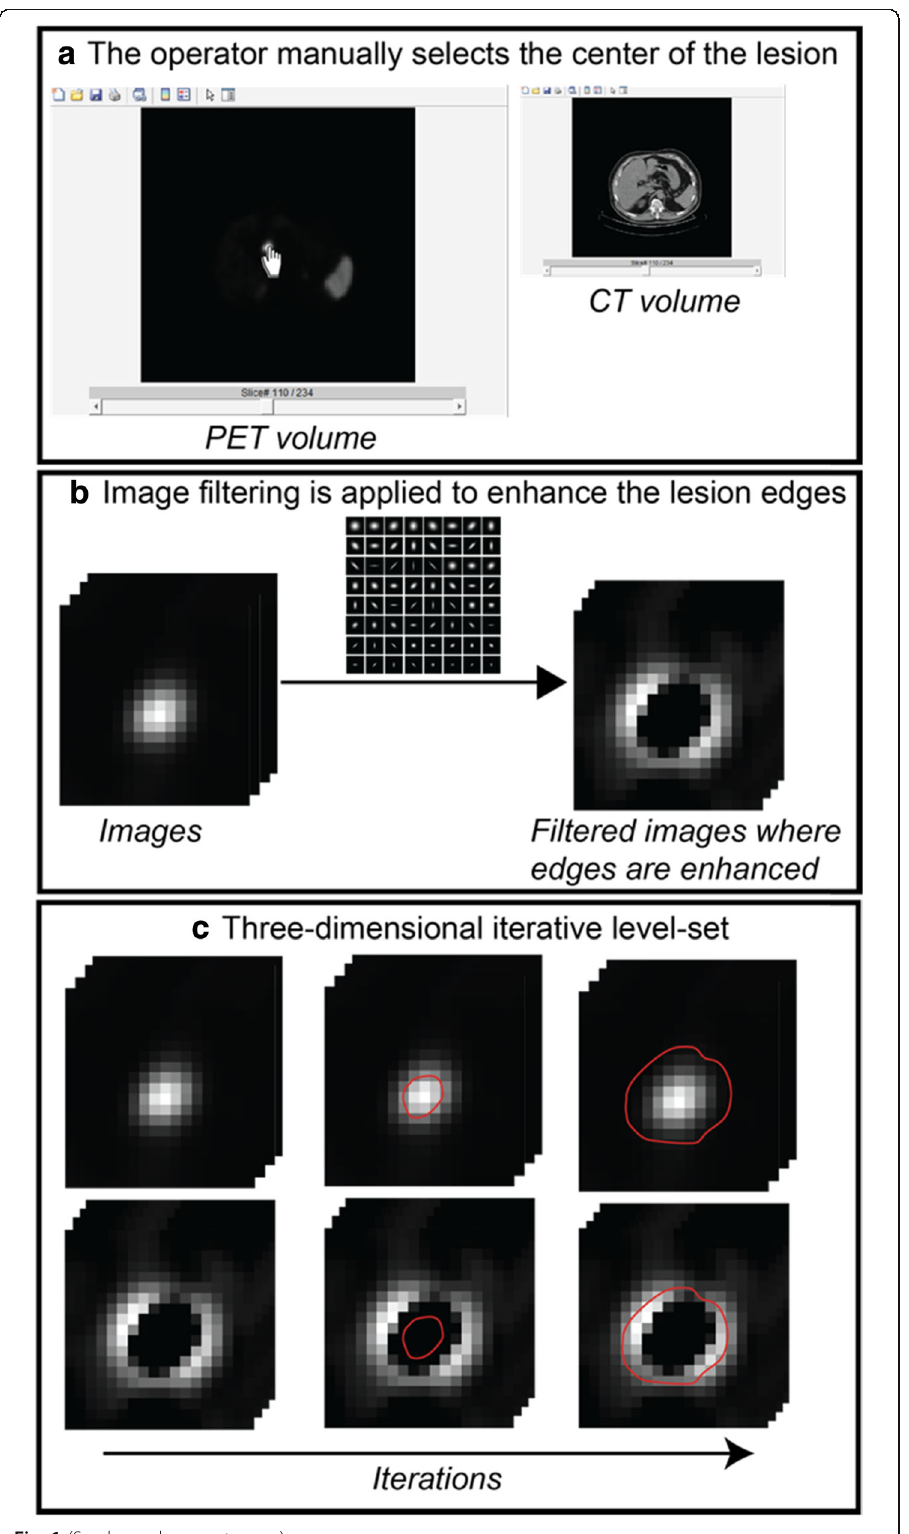
Fig. 1 (See legend on next